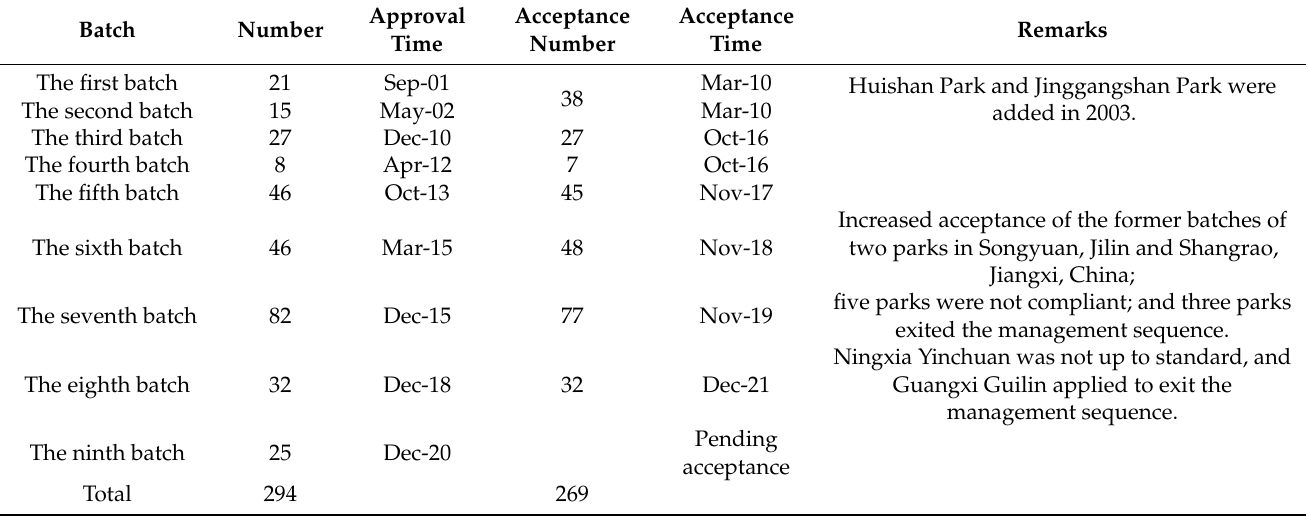
Table 1. Construction and acceptance of